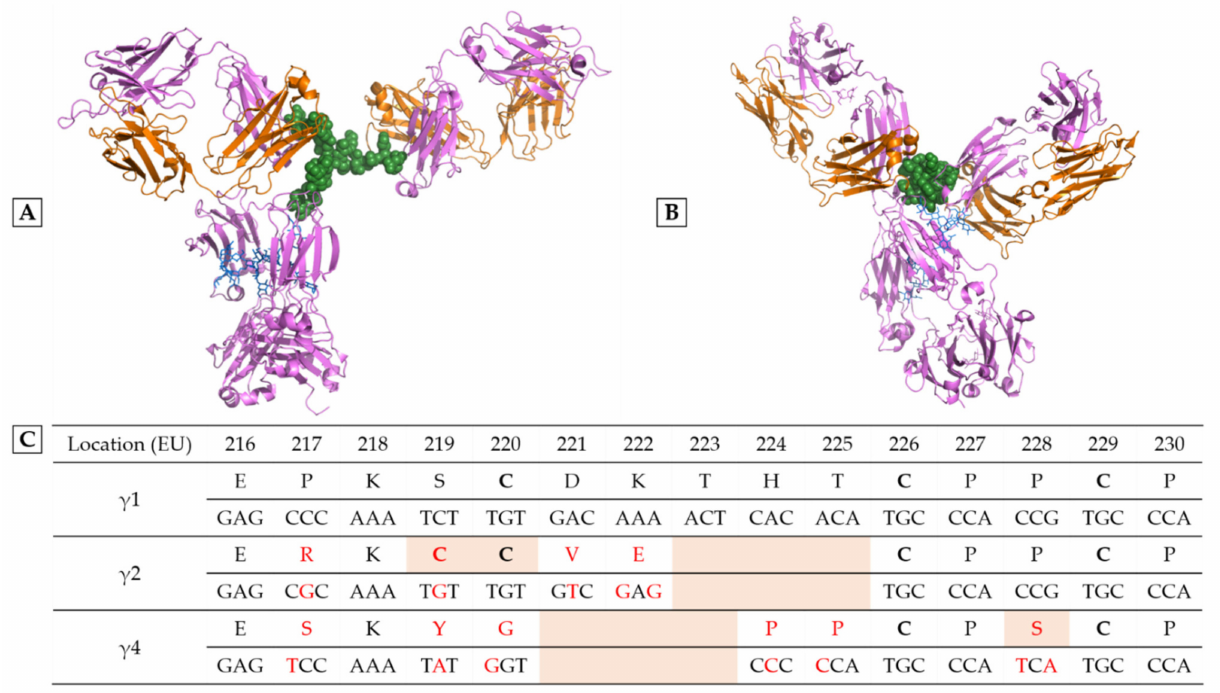
Figure 1. Differences between human IgG subclasses in the hinge region. Structure of an IgG1 ( A ) and an IgG4 ( B ), the only two human IgG subclasses that have been crystallized in their entirety. The heavy chains are colored in pink, the light chains in orange; N-glycans are indicated in blue, and the hinge regions in green. Figures were elaborated using PyMOL Molecular Graphics System, version 1.7.4 (Schrödinger) from PDB file 1HZH representing the unique human IgG1 crystallized, named B12 and directed against the gp120 of HIV (human immunodeficiency virus) and from PDB file 5DK3 representing pembrolizumab, the only human IgG4 crystallized (G4e1 variant). The high flexibility of the IgG1 hinge region gives freedom to the Fab arms and causes strong asymmetry of the whole molecule. Unfortunately, there is no available structure of an entire human IgG2. ( C ) Hinge region alignment of heavy chains γ 1, γ 2, γ 4. Amino acids (according to EU numbering) and nucleotides that differ to IgG1 sequence are colored in red. Cysteines engaged in disulfide bridge are in bold. Notable differences appear in orange background: 3 amino acids deletion in IgG2 and IgG4, cysteines 219 and 220 of IgG2, and serine 228 of IgG4 (see text). Table 1. Updated version of the nomenclature of G1e variants of IgG1, with a focus on silent (blue highlighting 1 ) and boosted antibodies (red highlighting 1 ), and immunostimulatory antibodies highlighted in capital